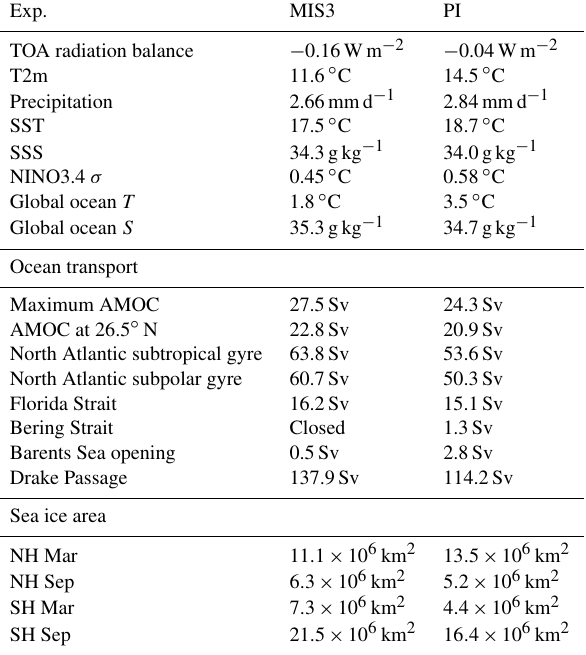
Table 2. Global mean values for the MIS3 and PI experiments (both averaged between years 1801 and